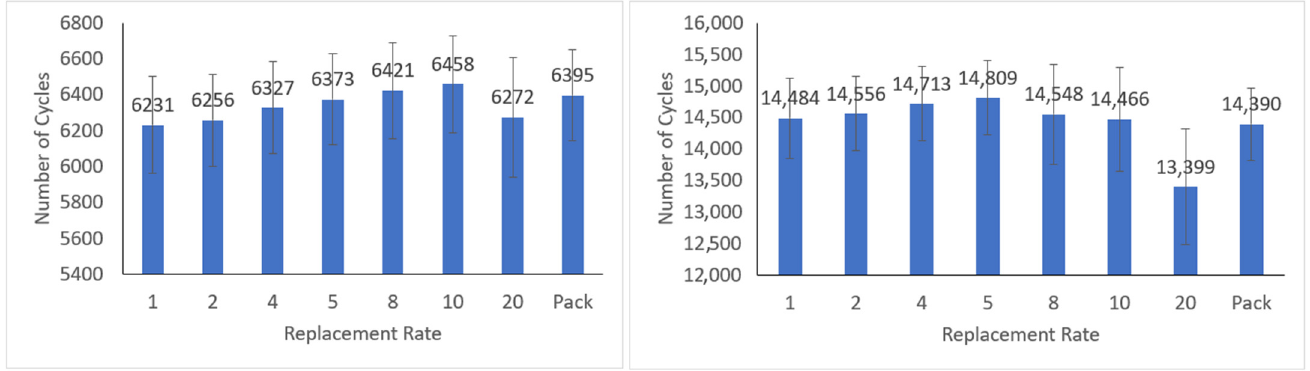
Figure 7. Total number of cycles, on average, of the battery packs with different replacement rates, for 80% SOH threshold ( left ), and 70% SOH threshold ( right ).